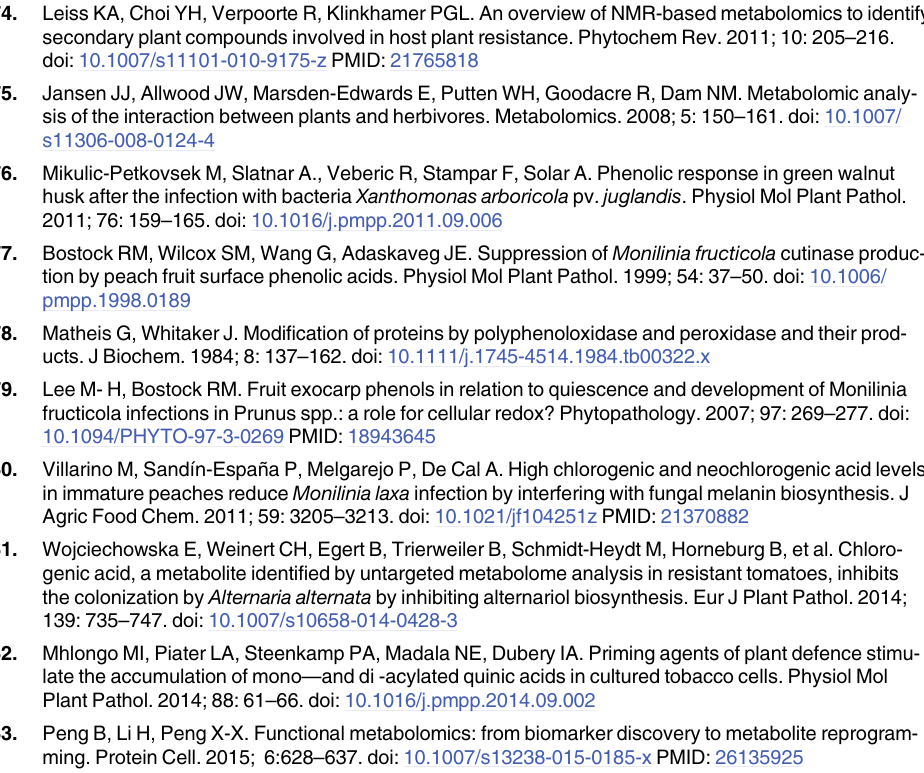
PLOS ONE | DOI:10.1371/journal.pone.0151350 March 15,